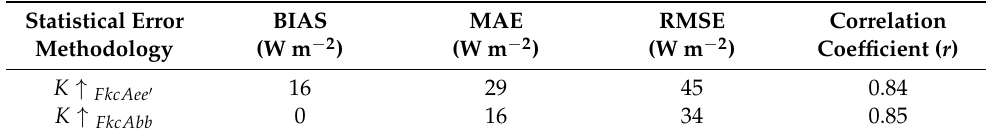
Table 8. Statistical errors for outgoing solar irradiance for two models for the calculated albedo: (1) Nyren and Gryning [37] and (2) optimized (no BIAS) Beljaars and Bosveld [38] methodology.